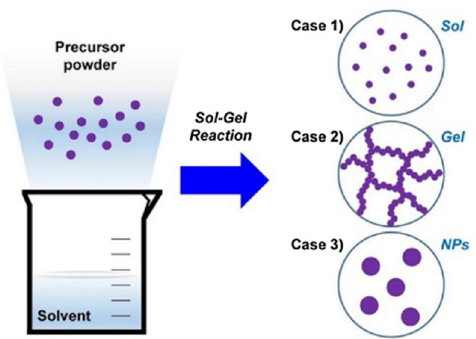
Figure 5. Typical sol–gel metal oxide reaction products [40]. Reprinted with permission from [40]; 2017 Elsevier.